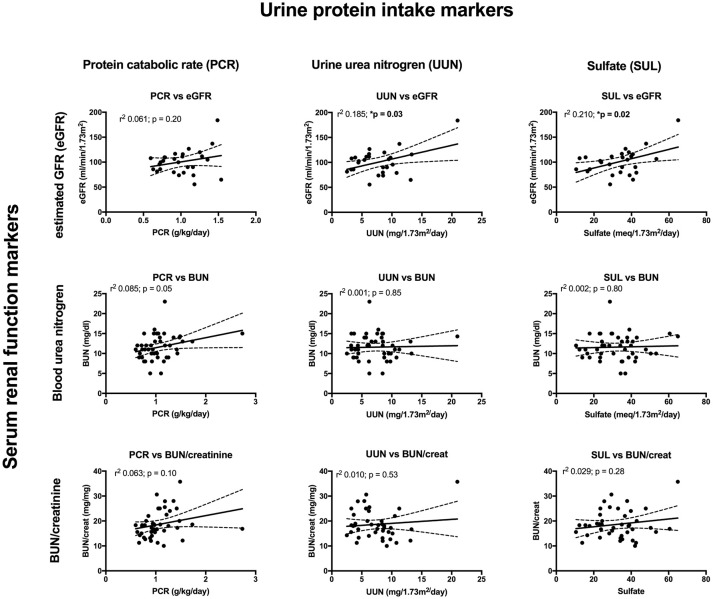
The correlations between urine markers of dietary protein intake consisting of urine protein catabolic rate (PCR) (left), urine urea nitrogen (UUN) (middle), and urine sulfate (SUL) (right), compared to eGFR (top), serum BUN (middle), and serum BUN/creatinine (bottom). The correlation between PCR and BUN just missed significance while there was a significant correlation between UUN and eGFR along with SUL and eGFR.